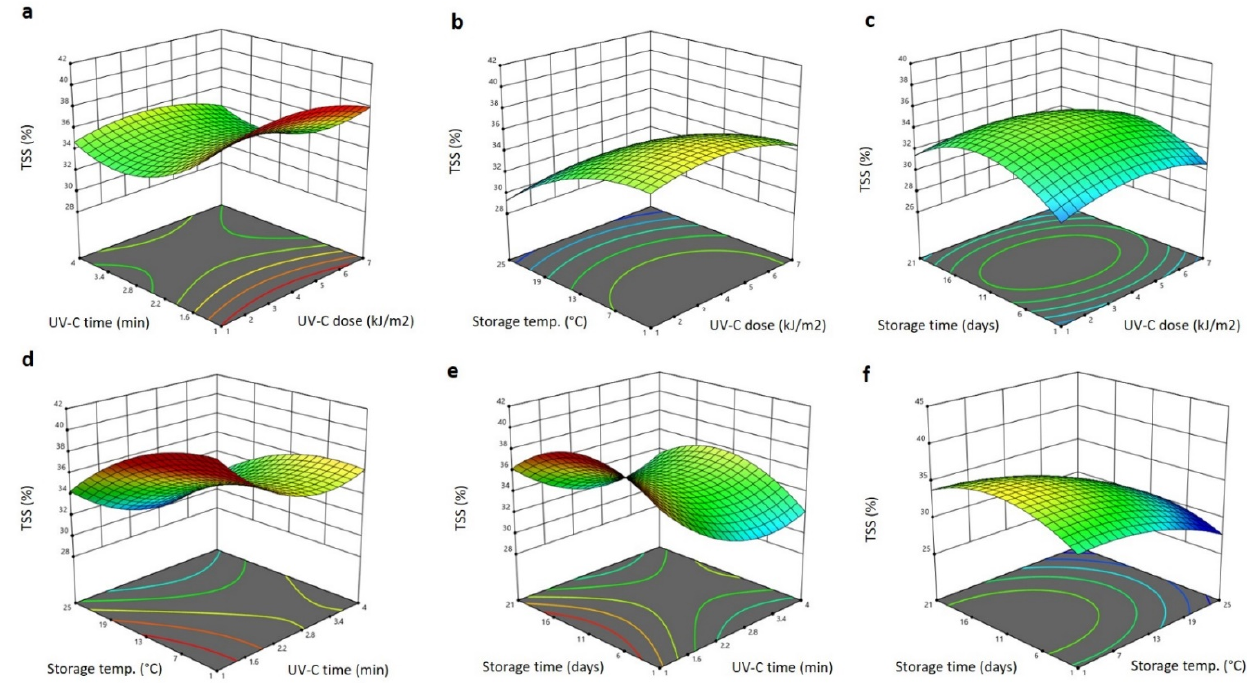
Figure 1. Response surface plots of total soluble solids (TSS) of Barhi dates as a function of UV-C time and UV-C dose ( a ), storage temperature and UV-C dose ( b ), storage time and UV-C dose ( c ), storage temperature and UV-C time ( d ), storage time and UV-C time ( e ), and storage time and storage temperature ( f ).